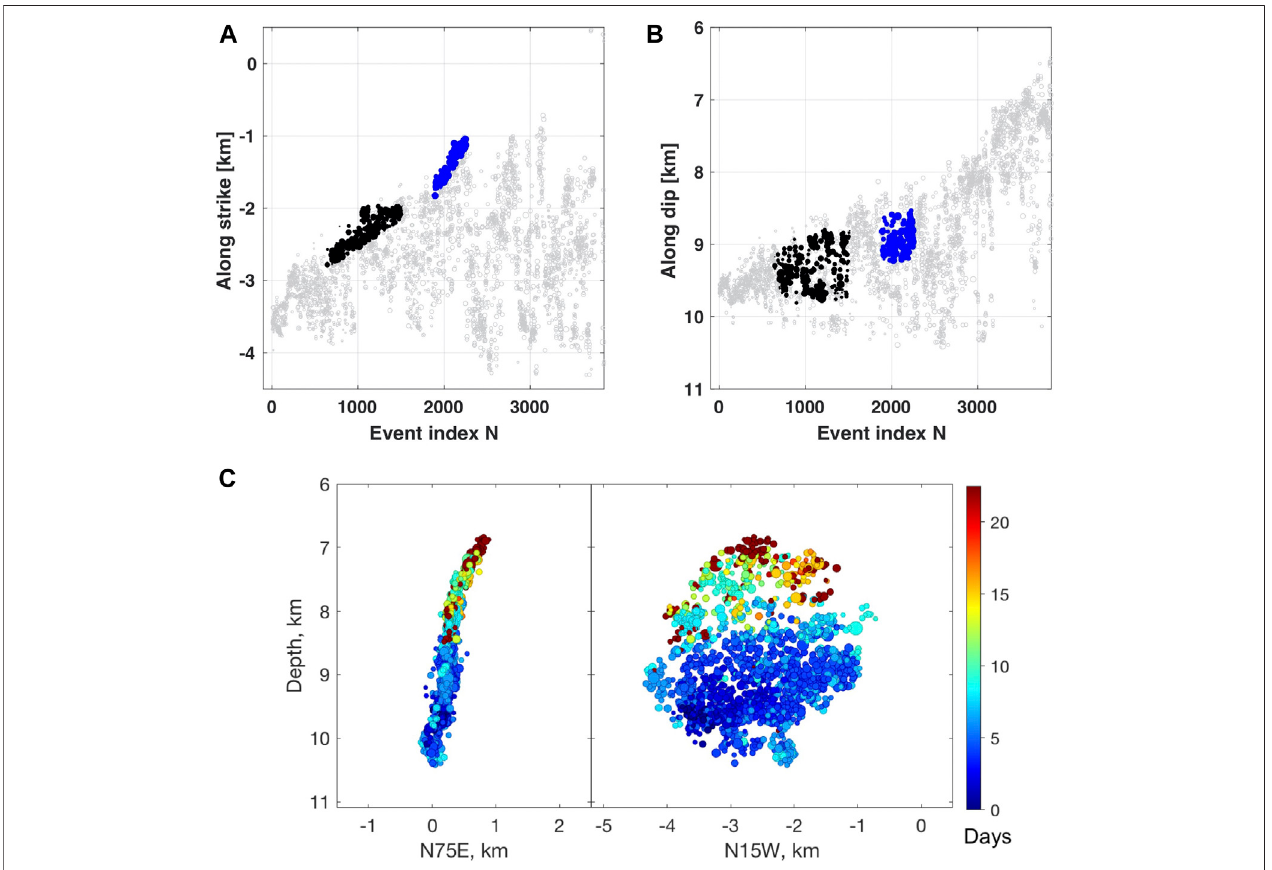
FIGURE 4 | The 2008 earthquake swarm in West-Bohemia showed prevailing unidirectional growth of the seismicity front in the strike-ward (A) and upward (B) directions. Two linearly growing clusters were selected in the strike direction for the analysis. The triggering front of the earlier cluster (black) growed slower than that of the later cluster (blue) . To measure the distance between the points needed for removing outliers, the event index was transformed into a distance in km so that the aspect ratio of the diagram was 1:1. In (C) , two vertical sections show the planar character of the swarm activity; the symbol color is proportional to the event origin